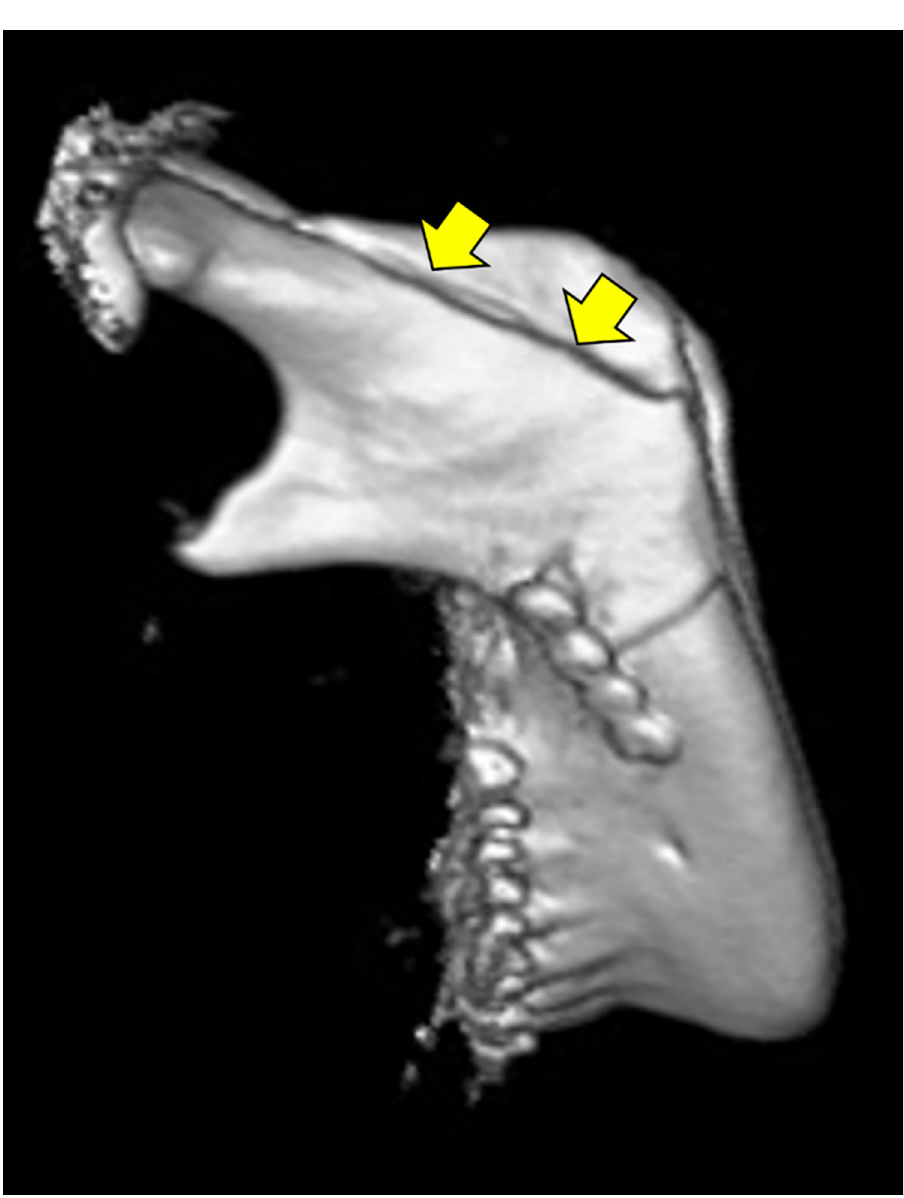
Fig 2. Representative three-dimensional image of an undesirable buccal split during SSRO. The yellow arrows indicate a bad split in the buccal plate of the ramus. were no significant differences in angle ACB and the thickness of the distal region of the corti- cal bone between the good split group and the bad split group (Fig 3A and 3B). On the other hand, there was a statistically significant difference in the ratio of EM to JK between the two groups ( p = 0.037) (Fig 3C). In addition, the distal region of the cortical bone in the bad split group tended to be thicker ( p = 0.099) (Fig 3D), and angle LNI in the bad split group tended to be smaller than in the good split group ( p = 0.087) (Fig 3E), although the difference was not statistically significant. There were also no significant differences in angle DFH and the dis- tance of GI between the two groups (Fig 3F and 3G). In four patients of the good split group and one patient of the bad split group, the mandibular foramen was in direct contact with the